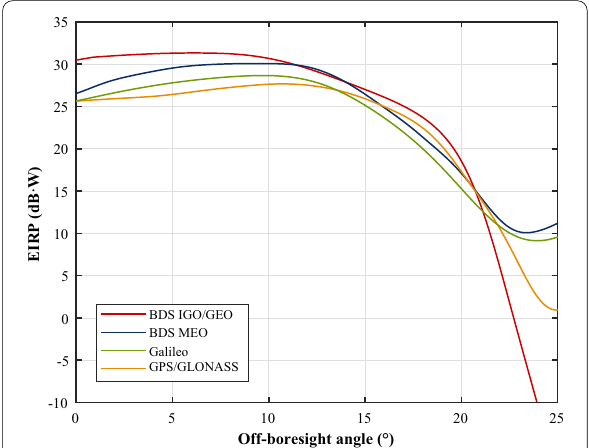
Fig. 3 EIRP settings of each constellation in this simulation (Liu et al. 2016, 2017; Steigenberger et al. 2017; Thoelert et al. 2019) Table 2 Signal band